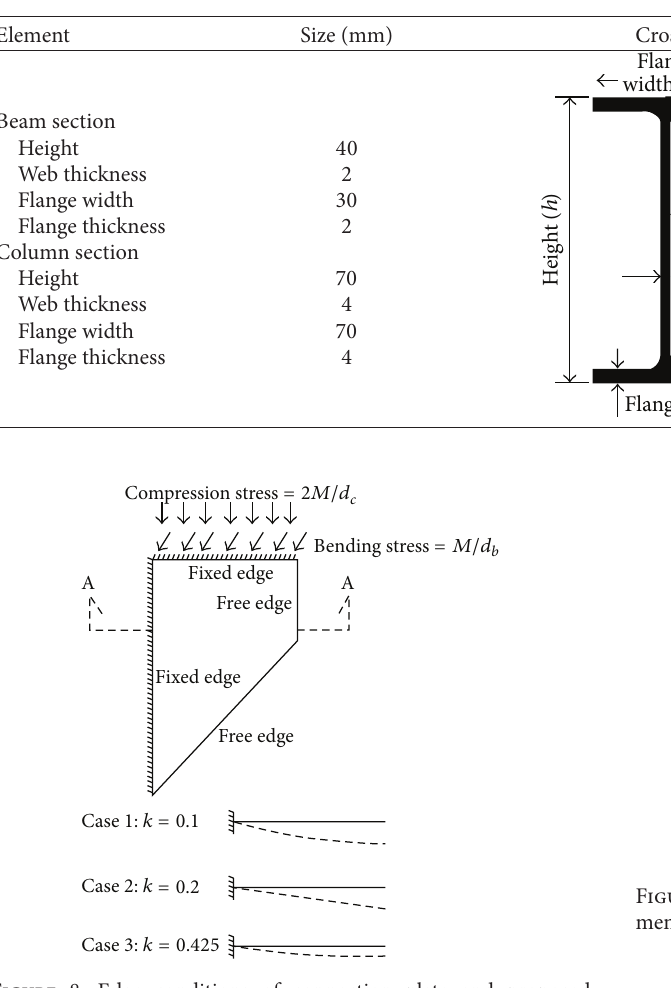
Figure 8: Edge conditions of connection plate and proposed buckling coefficients, 𝑘 .